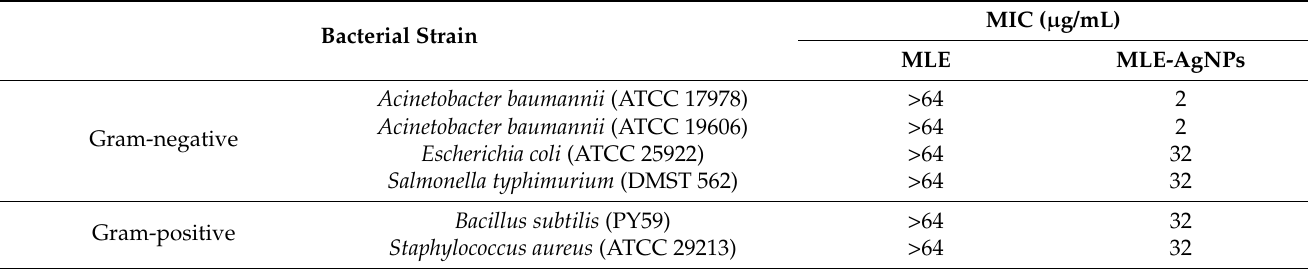
Table 2. Minimum inhibitory concentration (MIC) of MLE and MLE-AgNPs against Gram-negative and Gram-positive bacteria.